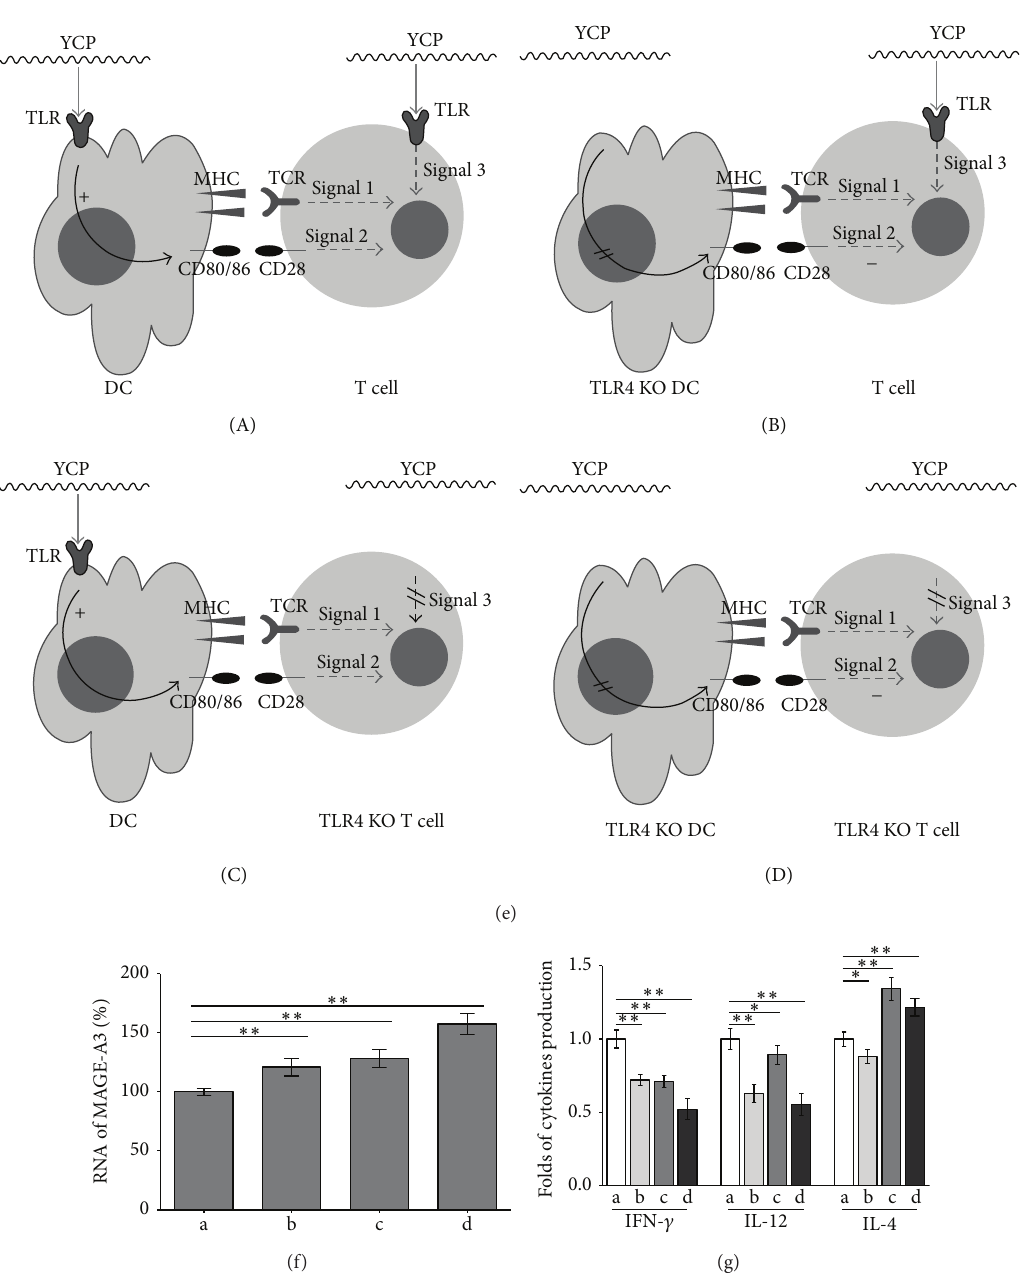
Figure 4: The effect and mechanism of YCP on the specific immunity enhancement. (a) The target cells (B16F10 cells) stimulated by medium or YCP (100–800nM) for 48 h directly. The number of target cells was measured by the mRNA quantitation of MAGE-A3. (b) The effector cells (T cells were cultured with mDCs at the ratio of 20 :1 for 48 h) and target cells (B16F10 cells) were cocultured and stimulated by medium or YCP (100–800nM) for 48h. The number of target cells was measured by the mRNA quantitation of MAGE-A3. (c) The populations of CD4 + T cells and CD8 + T cells treated by medium or YCP (400nM) were detected by flow cytometry during the incubation (0h, 6 h, 12h, 24 h, 48h, and 96 h). (d) The expressions of IFN- 𝛾 , IL-12, and IL-4 concentration in supernatants were measured using ELISA assay after the incubation at 48h. (e) Four cell groups were prepared to study the signal provided by YCP during in vitro specific immune responses as follows: (a) matured DCs (WT) and T cells (WT), (b) matured DCs (TLR4 KO) and T cells (WT), (c) matured DCs (WT) and T cells (TLR4 KO), and (d) matured DCs (TLR4 KO) and T cells (TLR4 KO). (f) The effector cells (T cells were cultured with mDCs at the ratio of 20 :1 for 48 h) and target cells (B16F10 cells) were cocultured and stimulated by medium or YCP (100–800 nM) for 48h. The number of target cells in each group was measured by the mRNA quantitation of MAGE-A3. (g) The expressions of IFN- 𝛾 , IL-12, and IL-4 concentration in supernatants were measured using ELISA assay after the incubation in each group at 48 h ( 𝑛 = 6 , ∗ 𝑃 ≤ 0.05 , ∗∗ 𝑃 ≤ 0.01 by Mann-Whitney 𝑈